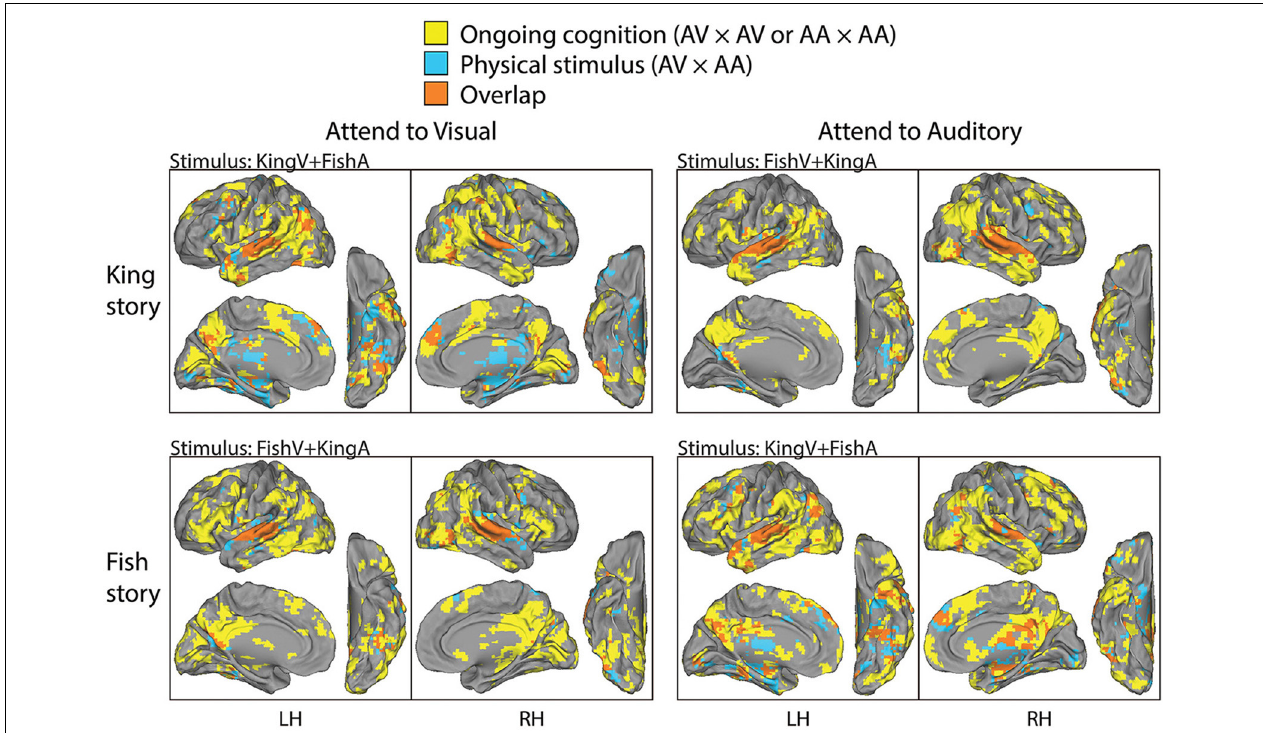
FIGURE 4 | Parcellation of brain areas modulated by physical stimulus and ongoing cognition. For each task condition, brain regions consistently modulated by that condition (the significant areas in the top or middle row in Figure 3 ) are overlaid with those modulated by the physical stimulus used in that condition (significant areas in the